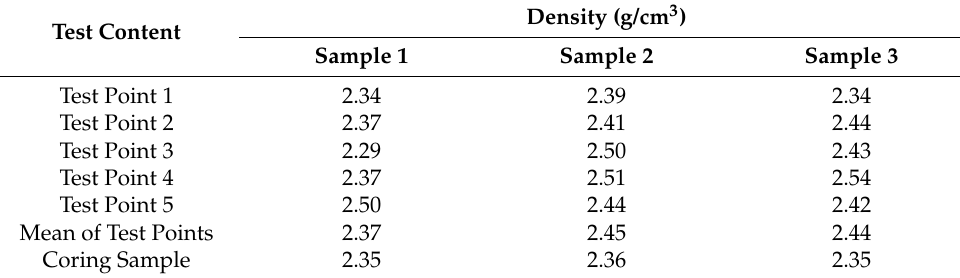
Table 2. Density calibration results of the non-nuclear density gauge.